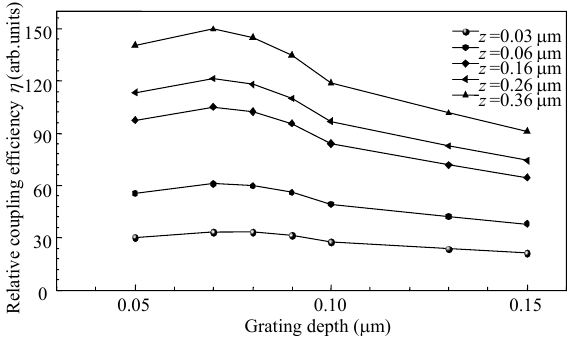
Fig. 6 Relative coupling efficiency with respect to grating